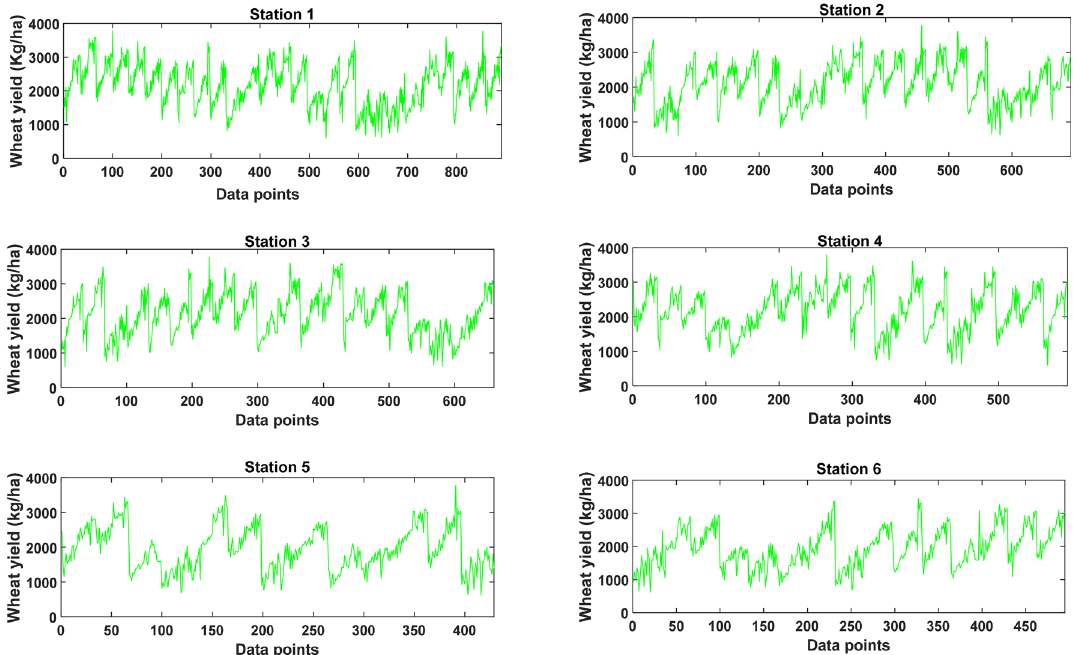
Figure 4. Time series of the annual wheat yield data for the training stations selected by the ant colony optimisation algorithm for each testing study station: Station 1: Rahimyar Khan, Station 2: D. G. Khan, Station 3: Kasur, Station 4: Sialkot, Station 5: Rawalpindi, and Station 6: